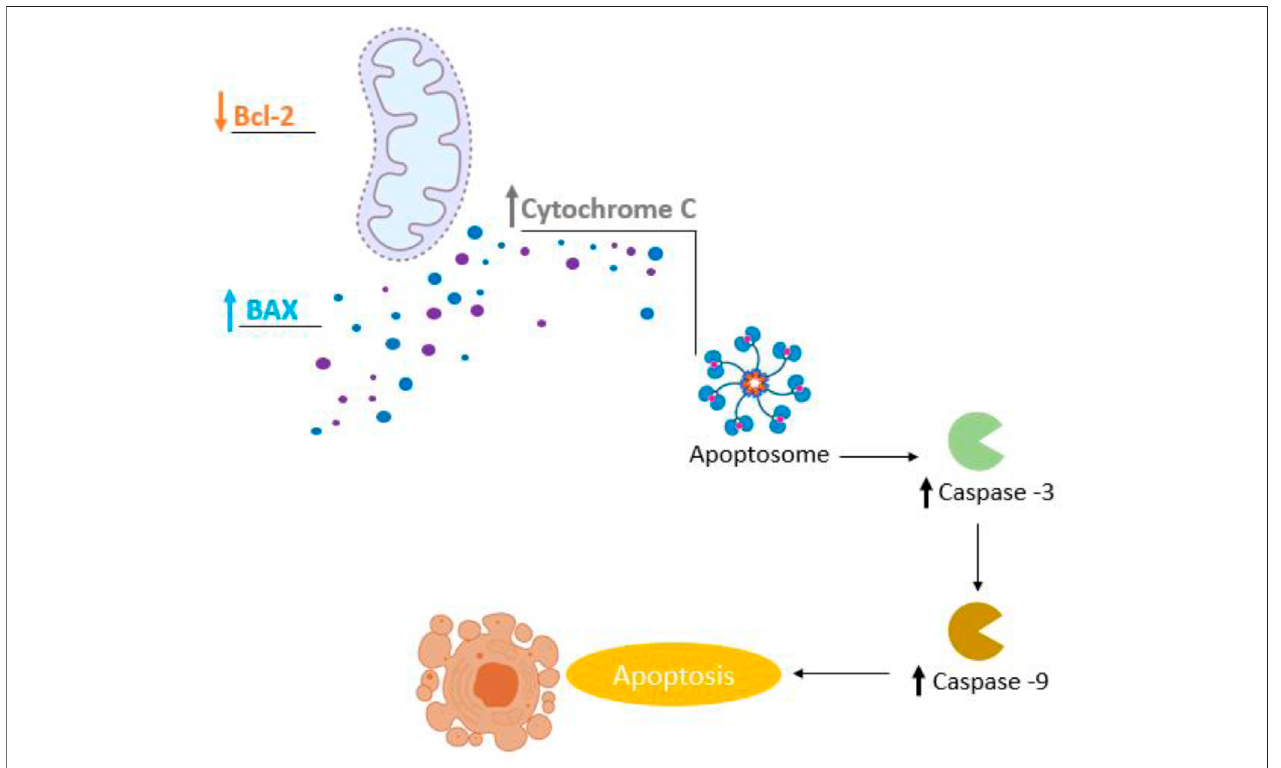
FIGURE 6 | Involvement of apoptosis in carvacrol and thymol treatment in